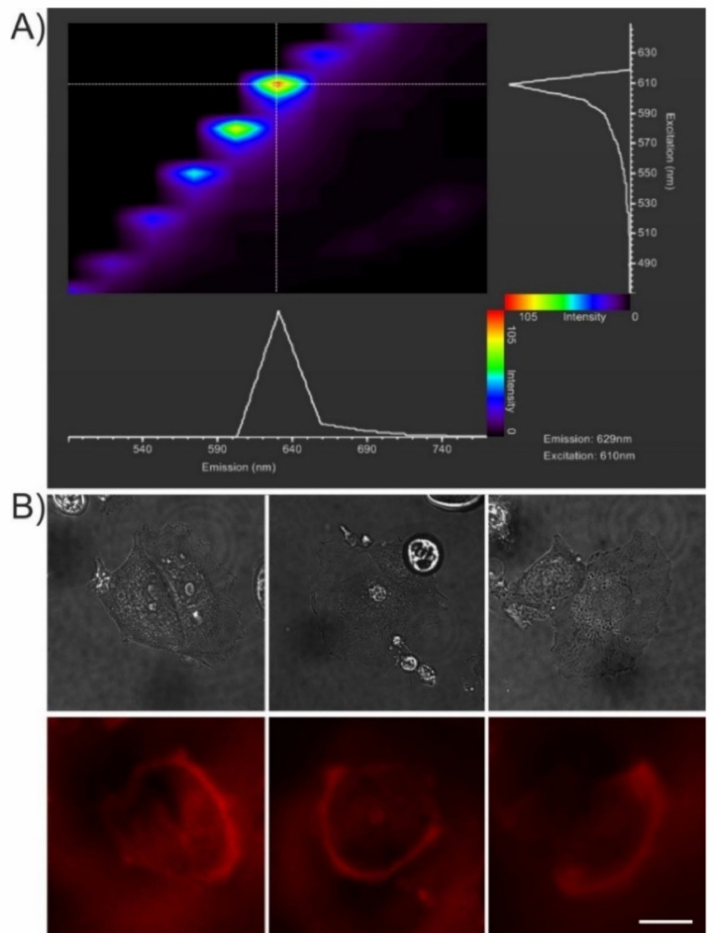
Figure 7. ( A ) Microspectrofluorimetry of CQD@Arg in the visible light range. The double-lambda plot of CQD@Arg adhered to the glass surface was obtained using excitation between 470–650 nm and detecting emission of fluorescence between 490–770 nm. The maximum emission was detected using excitation at 610 nm, and those conditions were used for cell imaging. ( B ) Living MCF-7 cells labelled with CQD@Arg imaged by confocal microscopy in transmission (upper row) and fluorescence (lower row) channels ( λ exc = 610 nm; λ em = 620–690 nm). Average fluorescence intensity projections of 3D stacks covering the cell thickness are shown in the fluorescence channel: scale bar, 20 µ